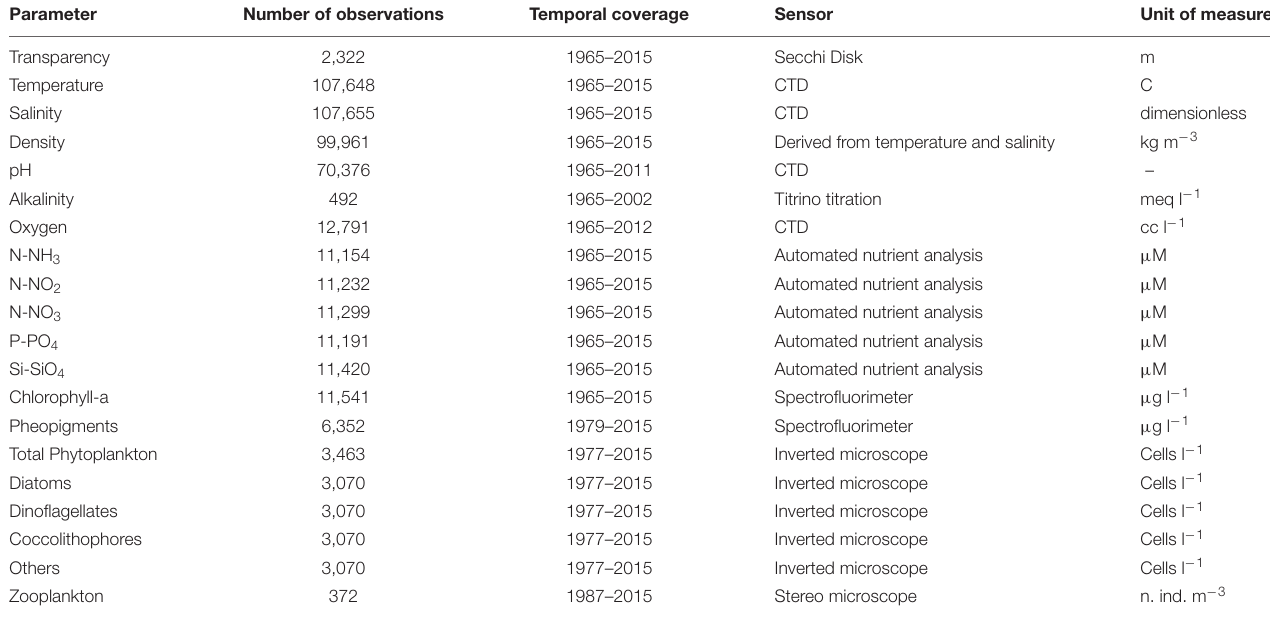
TABLE 1 | Parameters in the North Adriatic Sea (NAS) dataset with their main descriptive